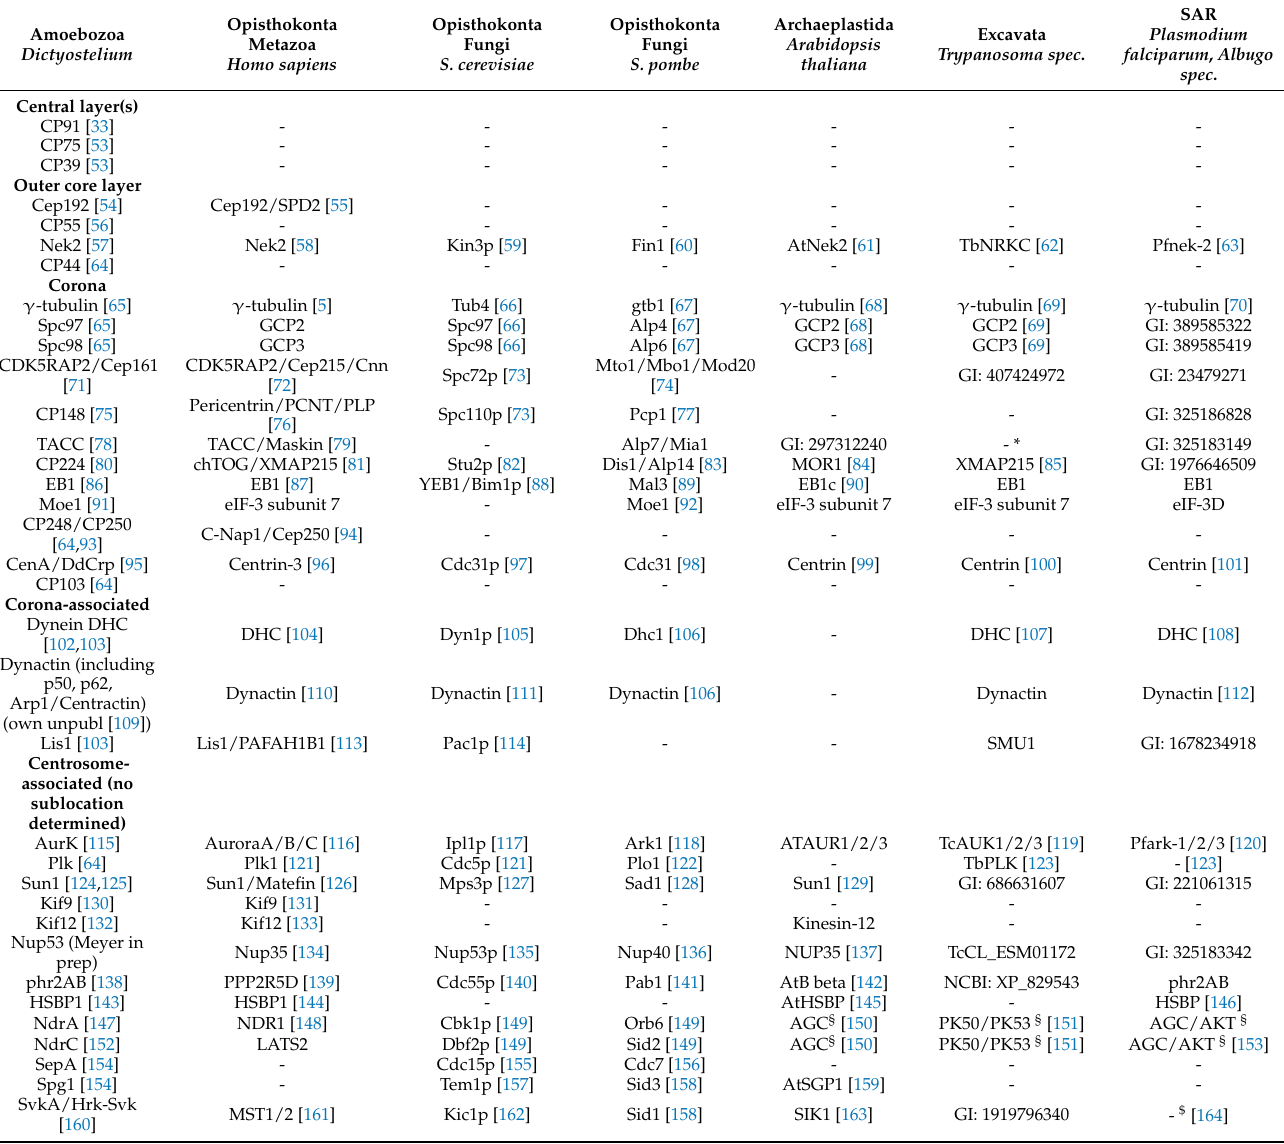
Table 1. Proteins localized at Dictyostelium